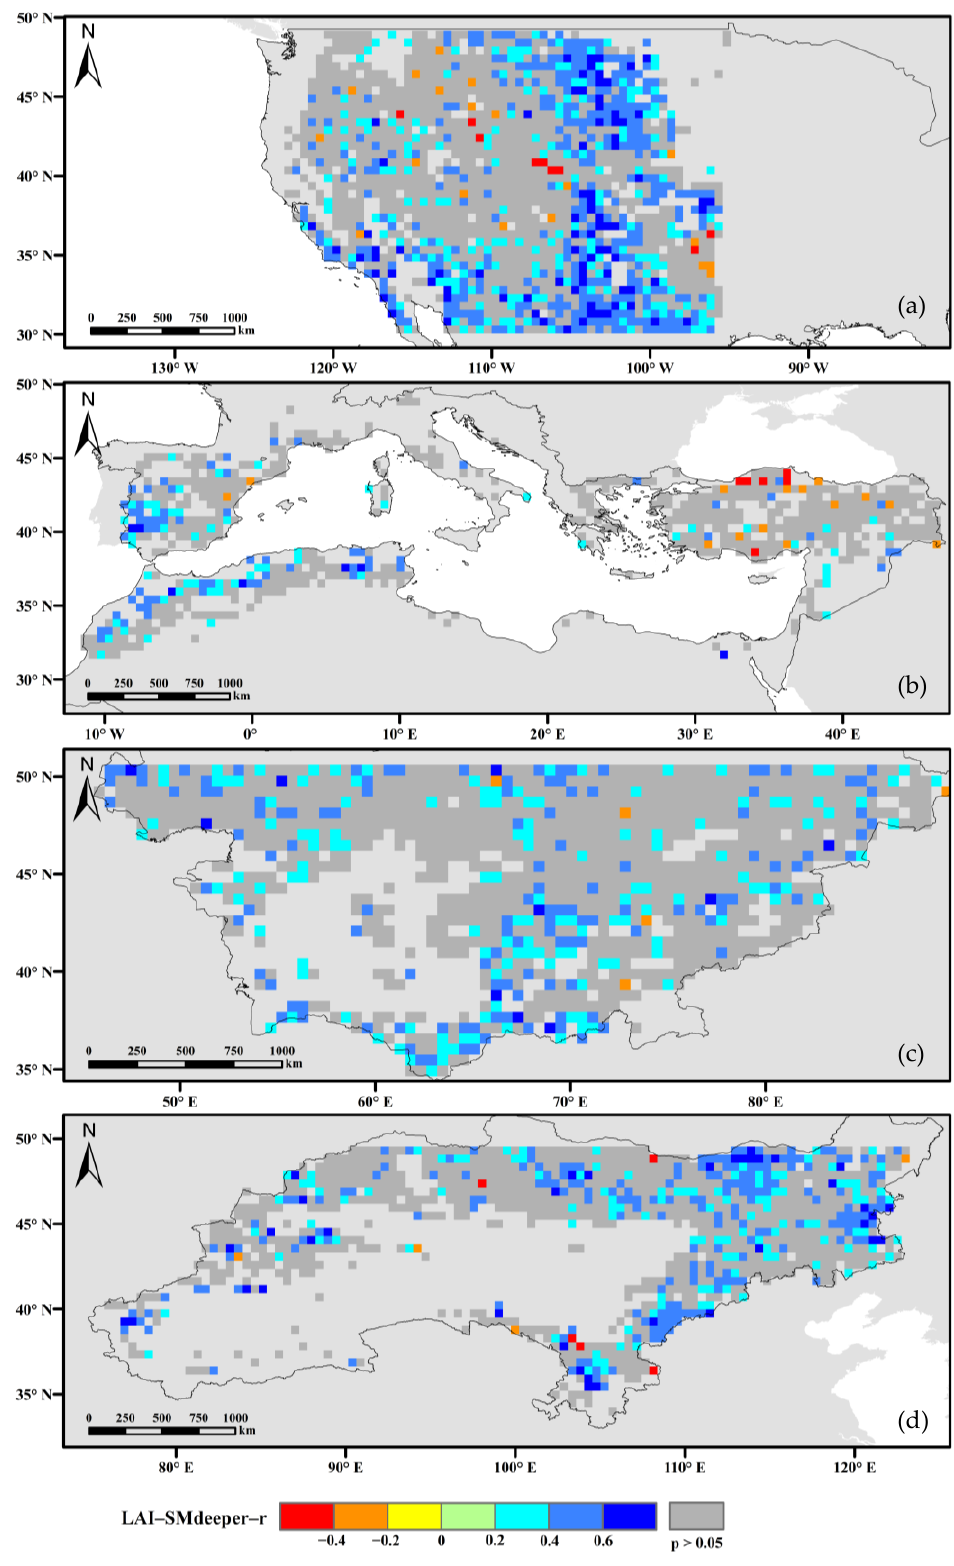
Figure A6. Relationship between the LAI and deeper soil moisture from 1981 to 2018 ( p < 0.05) in ( a ) North America, ( b ) Mediterranean region, ( c ) Central Asia, and ( d ) East Asia .